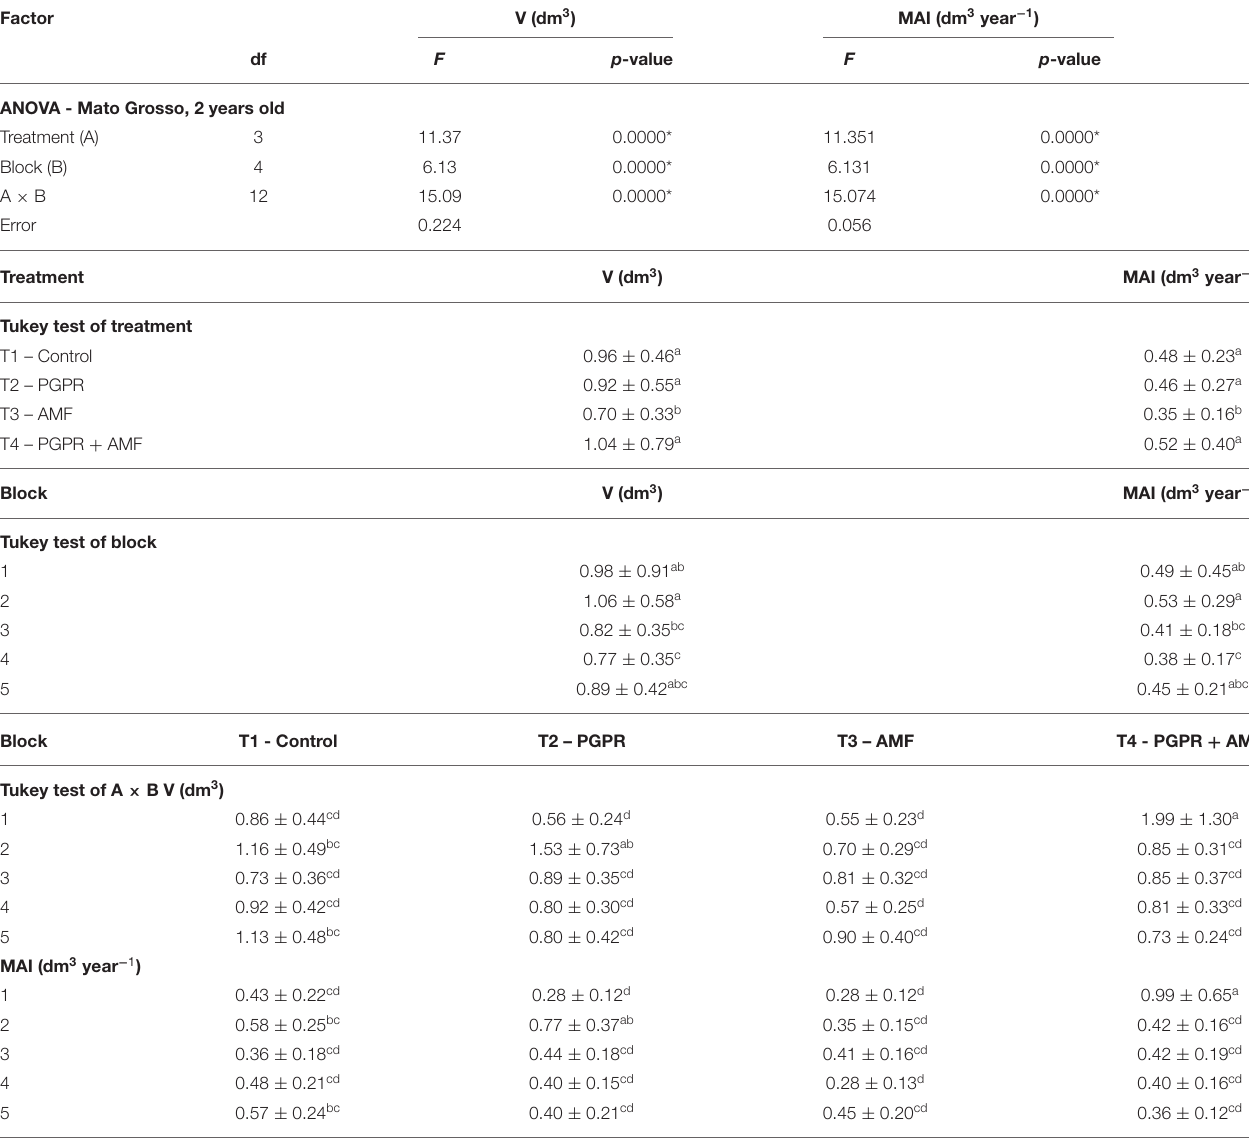
TABLE 6 | Tree volume and mean annual increment at 2 years old in plants of Tectona grandis in Mato Grosso state, Brazil.